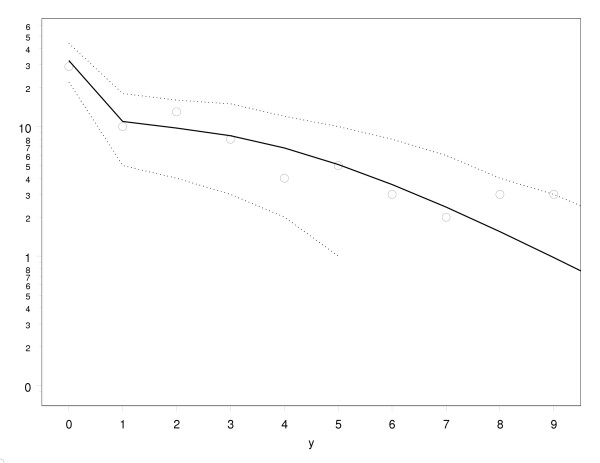
Frequencies of SAGE counts (restricted to genes mapped to a single tag) in IDC-3, given that the same tag had count 5 in HTM library 145. Compared to the expected frequencies and 95% confidence bounds from the bivariate model, restricted to tags with counts lower than 15 in both libraries.